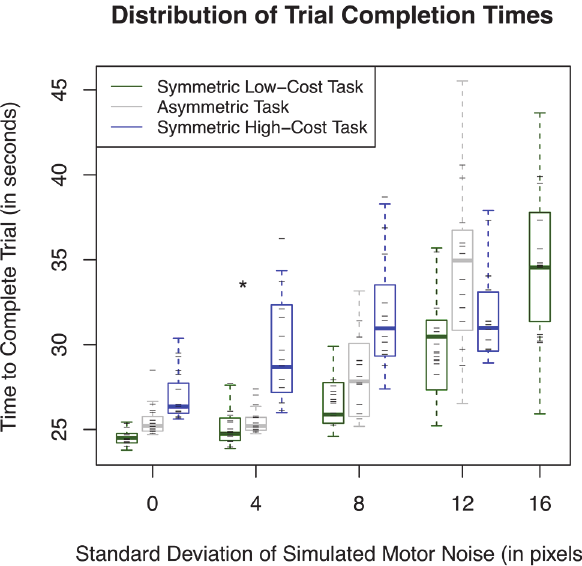
Fig 5. Box plot of subjects ’ average trial times. Dashes indicate the average time each subject took to complete that task. Notice in general the distribution is greater for higher risk tasks indicating the differences in subjects ’ risk awareness. The increase in distribution with increased motor noise demonstrates that some subjects were more adept than others at playing the game. The asterisk indicates the only pair of trial times that were not significantly